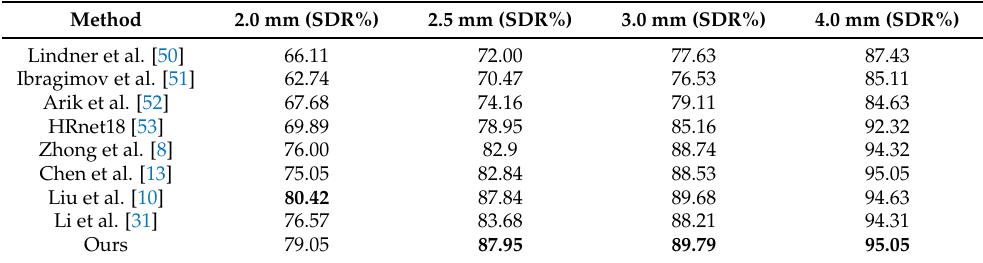
Table 6. Comparisons of SDR of our method with recent compelling methods on ISBI2015 test set (2).